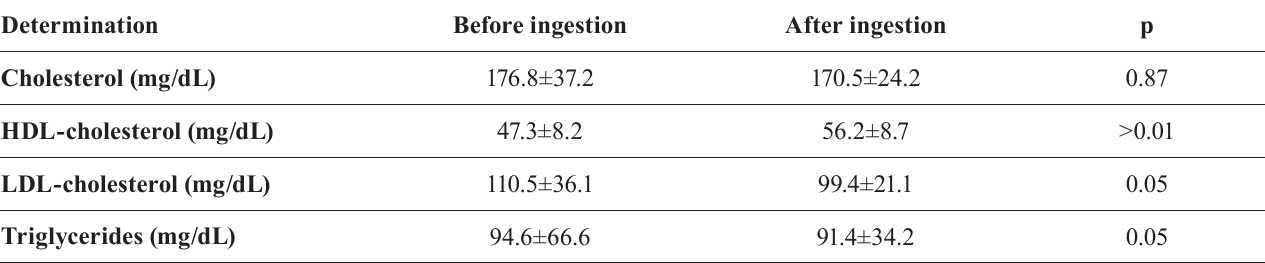
Table II - Lipid profile of the studied